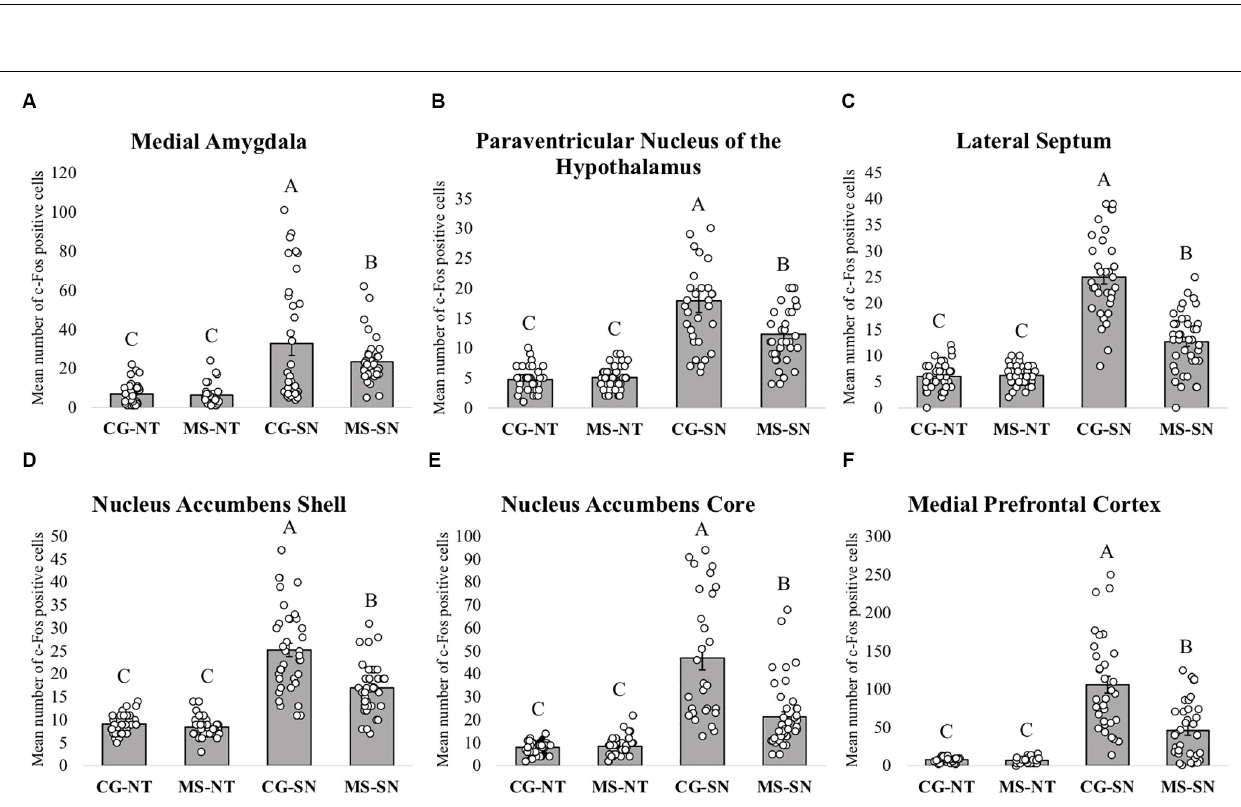
Frontiers in Behavioral Neuroscience |